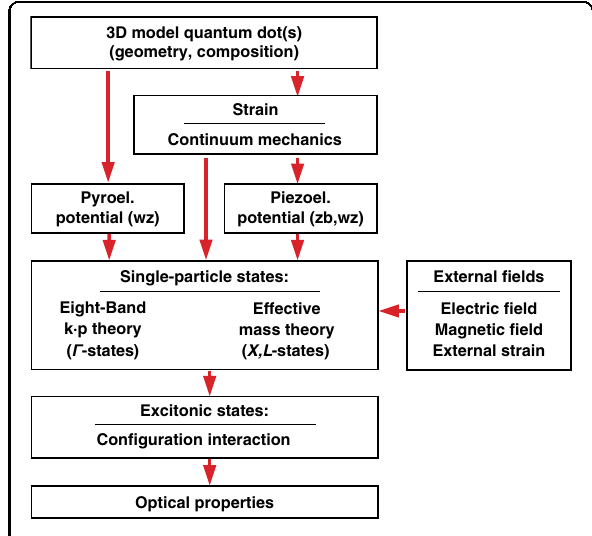
Fig. 1 Schematics of the general modeling